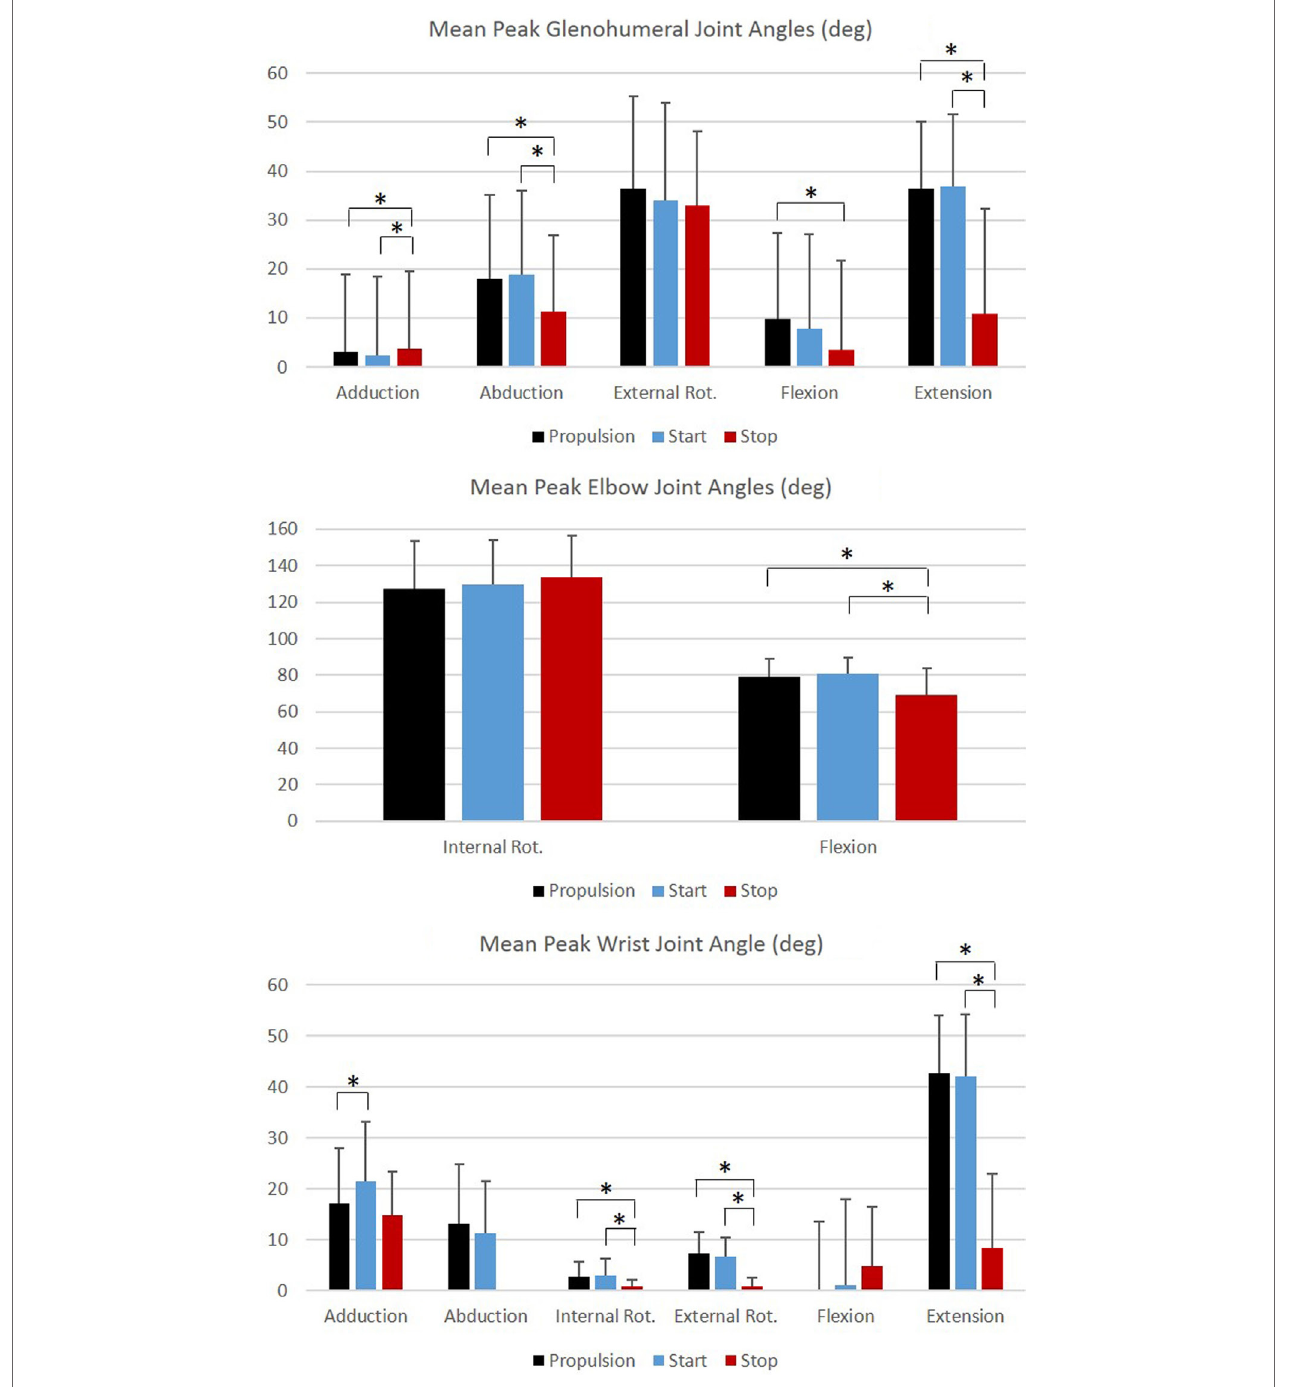
FigUre 6 | group mean peak joint angles (degrees) for the glenohumeral, elbow, and wrist joints during each functional mobility task, propulsion (black), start (blue), and stop (red) . One SD is represented by the thin vertical bar. Tasks connected by an asterisk are statistically significantly different ( p < 0.01).